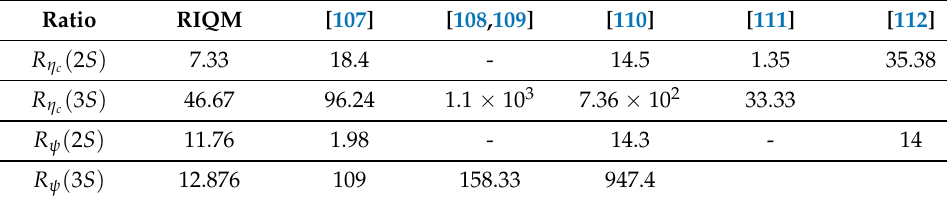
Table 3. LFU observables for B c -decays to radially excited charmonium states. Ratio RIQM [107] [108,109] [110] [111]